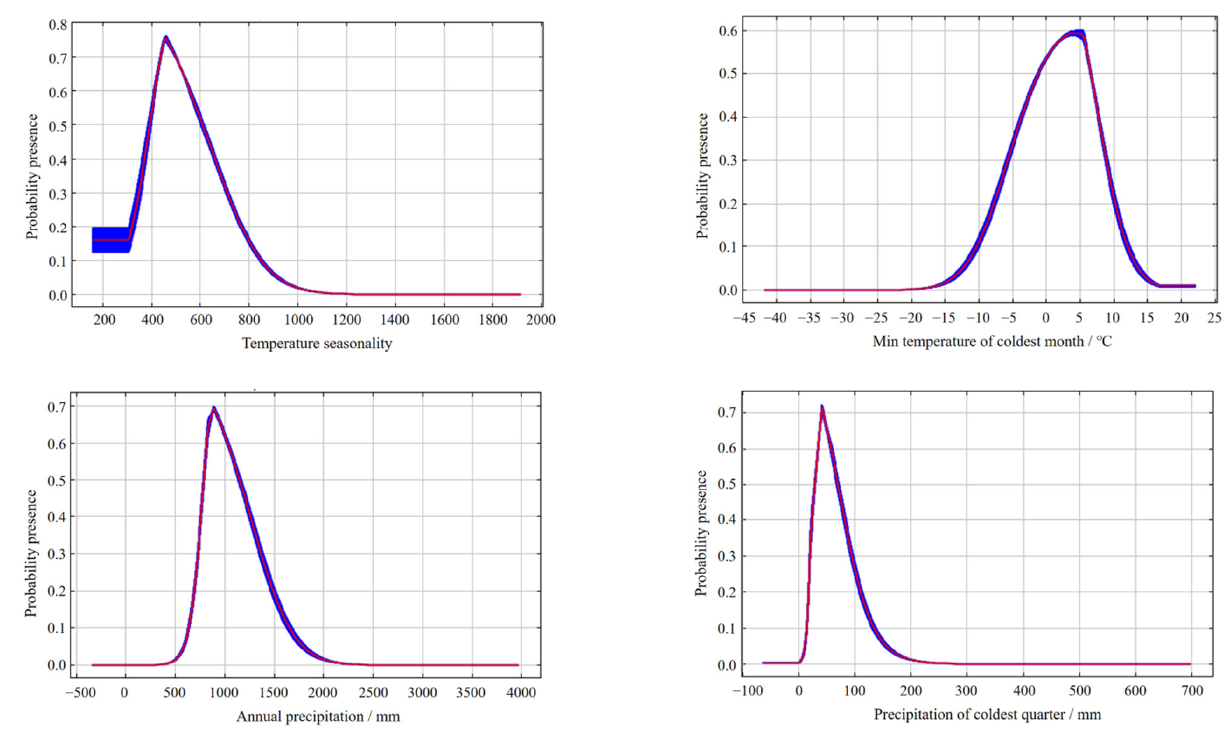
Figure 3. Single response curves of dominant environmental factors.